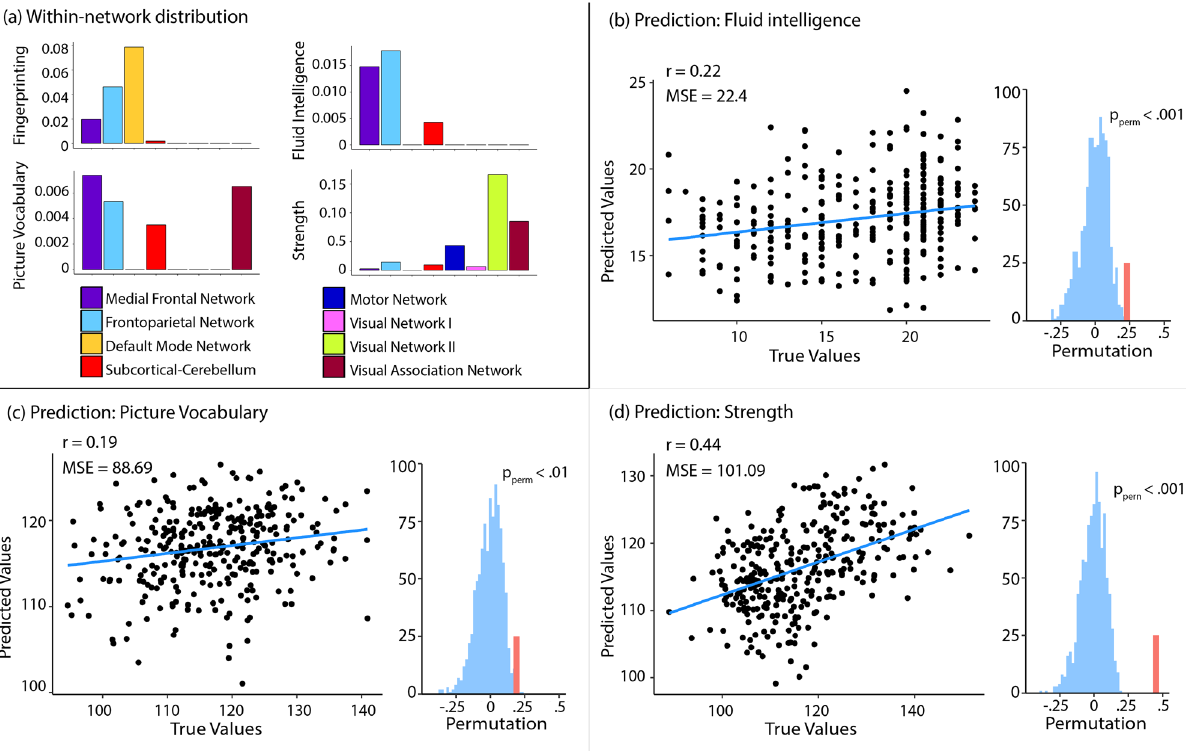
Fig. 1 Within-network distribution of selected edges in fi ngerprinting and behavioural prediction. a Visualises the percentage of selected edges for fi ngerprinting and for prediction within each network, adjusted for the total number of edges in each network. b – d shows the prediction results of three psychometric variables of interest. Language comprehension was evaluated using the picture vocabulary